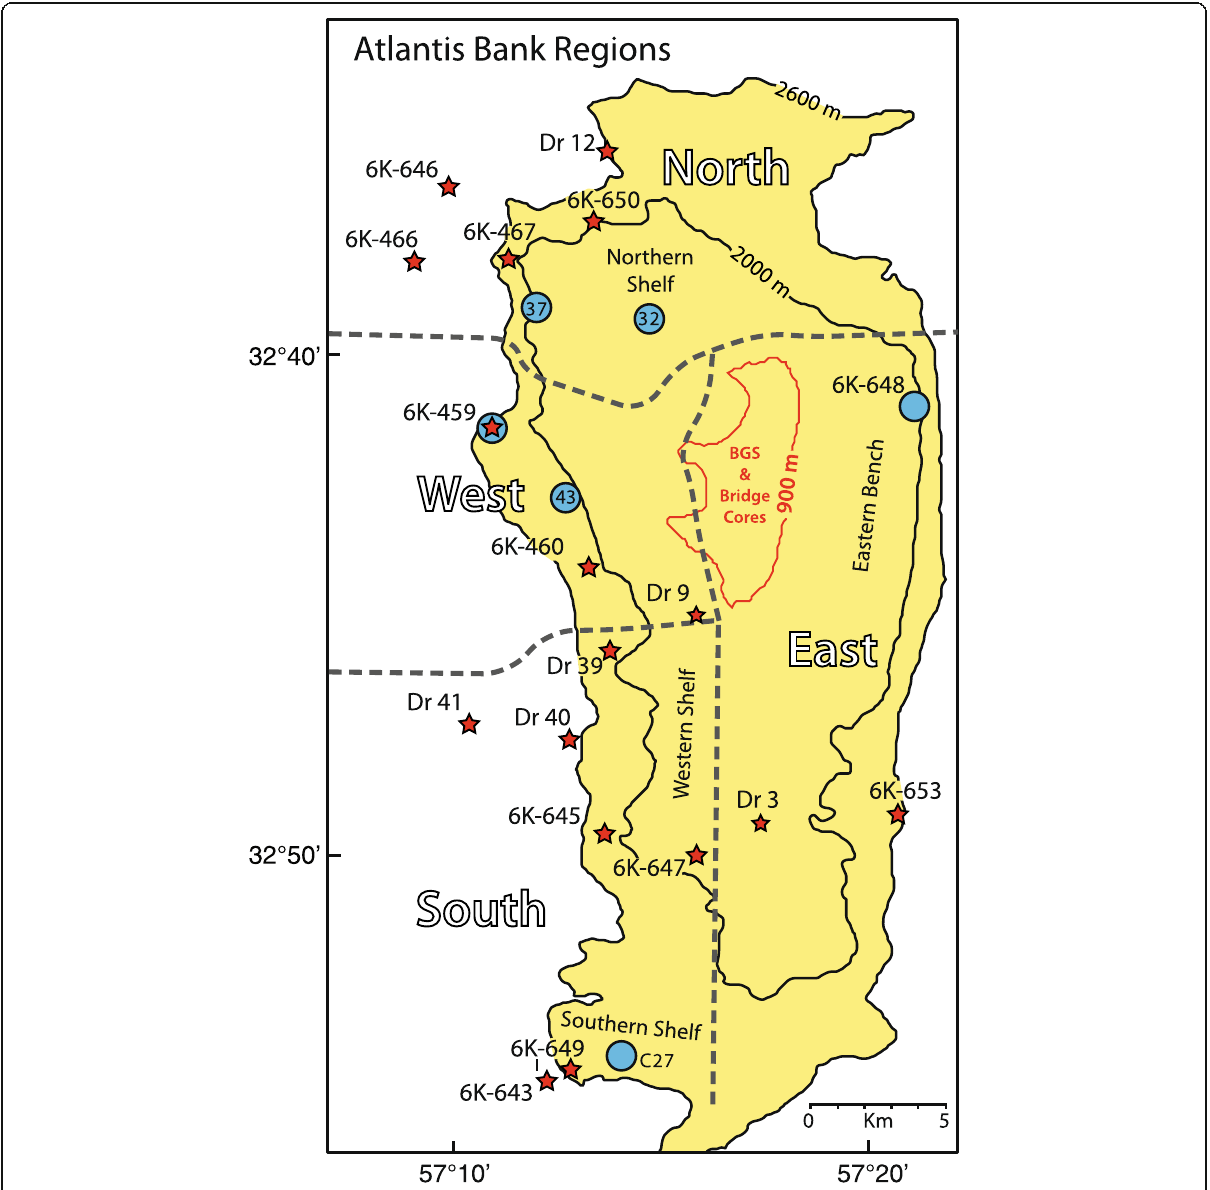
Fig. 4 Regional geographical and mineralogical divisions of Atlantis Bank. Dashed gray lines divide the northern, eastern, southern, and western regions as discussed in the text. Locations of samples selected for mineral analysis shown as red stars. Blue circles show location of oolitic limestones. Two-thousand-five-hundred-meter contour outlines the likely depth for sub-aerial erosion and shelf formation based on oolitic limestones sampled by dredging and diving. Two-thousand-meter contour shown for reference, whereas 900 m contour (in red) outlines the wave-cut platform at the crest of Atlantis Bank (see Fig.